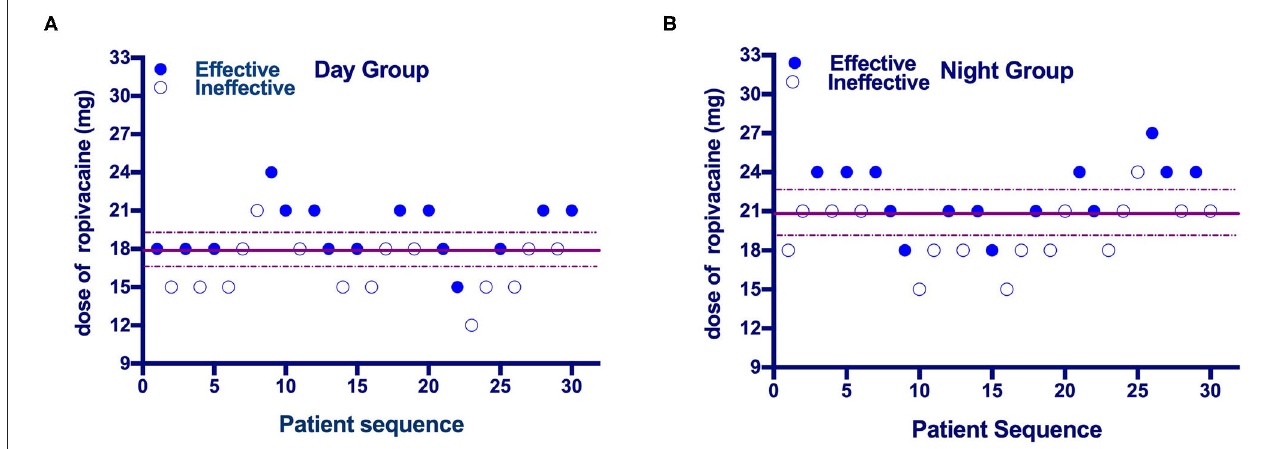
FIGURE 2 | (A,B) Individual response to epidural ropivacaine at a corresponding dose (mg). The median effective dose (ED 50 ) of epidural ropivacaine for labor analgesia was 17.9 (95% CI: 16.5 to 19.4) mg in the Day Group vs. 20.9 (95% CI: 19.2 to 22.7) mg in the Night Group. Solid lines represent the ED 50 values and dashed lines represent the 95% CI.